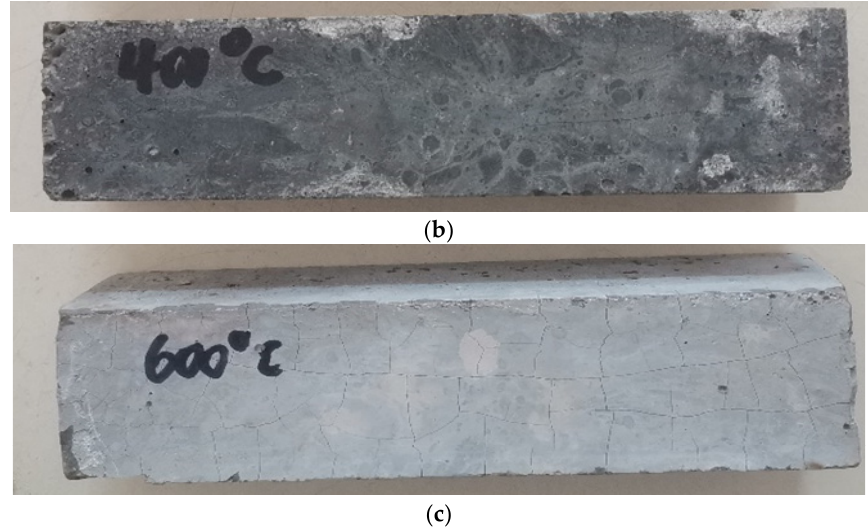
Figure 7. Typical photographs of R100 specimens with different high-temperature exposures. ( a ) 200 ℃ . ( b ) 400 ℃ . ( c ) 600 ℃ .